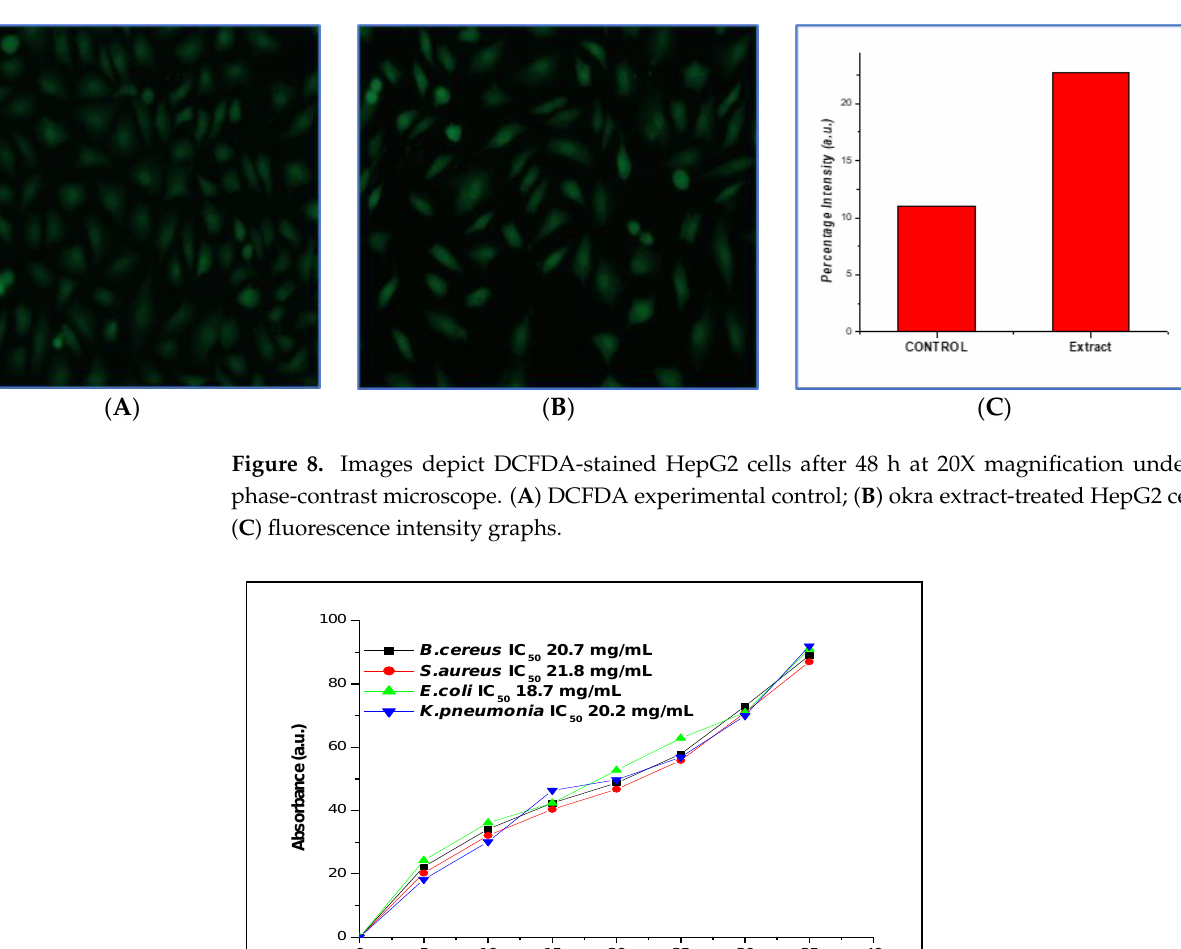
Figure 9. Graph showing antibacterial potential of okra extract against S. aureus (21.8 mg/mL), E. coli (18.7 mg/mL), B. cereus (20.7 mg/mL), and K. pneumoniae (20.2 mg/mL). The experiment was performed in triplicate, and the results are expressed as mean ± standard deviation.